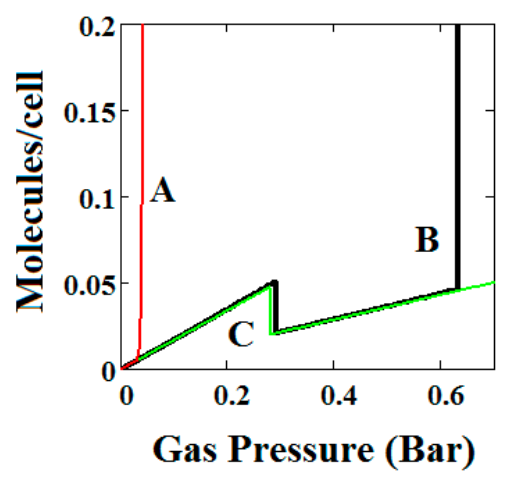
Figure 8. Plot of the behaviour of the methane adsorption in the theory MOF for three values of the parameter J ( A = − 2.29, B = − 1.49, C = − 0.573 kJ/mole). Curves B and C show NGA transformation. High J values cause the NGA transformation to disappear. The other parameters are T = 257 K, uglp = 14.8 kJ/mole, ugnp = 13.55 kJ/mole, ∆ = 0.025 kJ/mole, X = 5000 Å 3 , Y = 10,000 Å 3 , Nm = 40, scale = 0, nmaxlp = 21, nmaxnpb = 20.